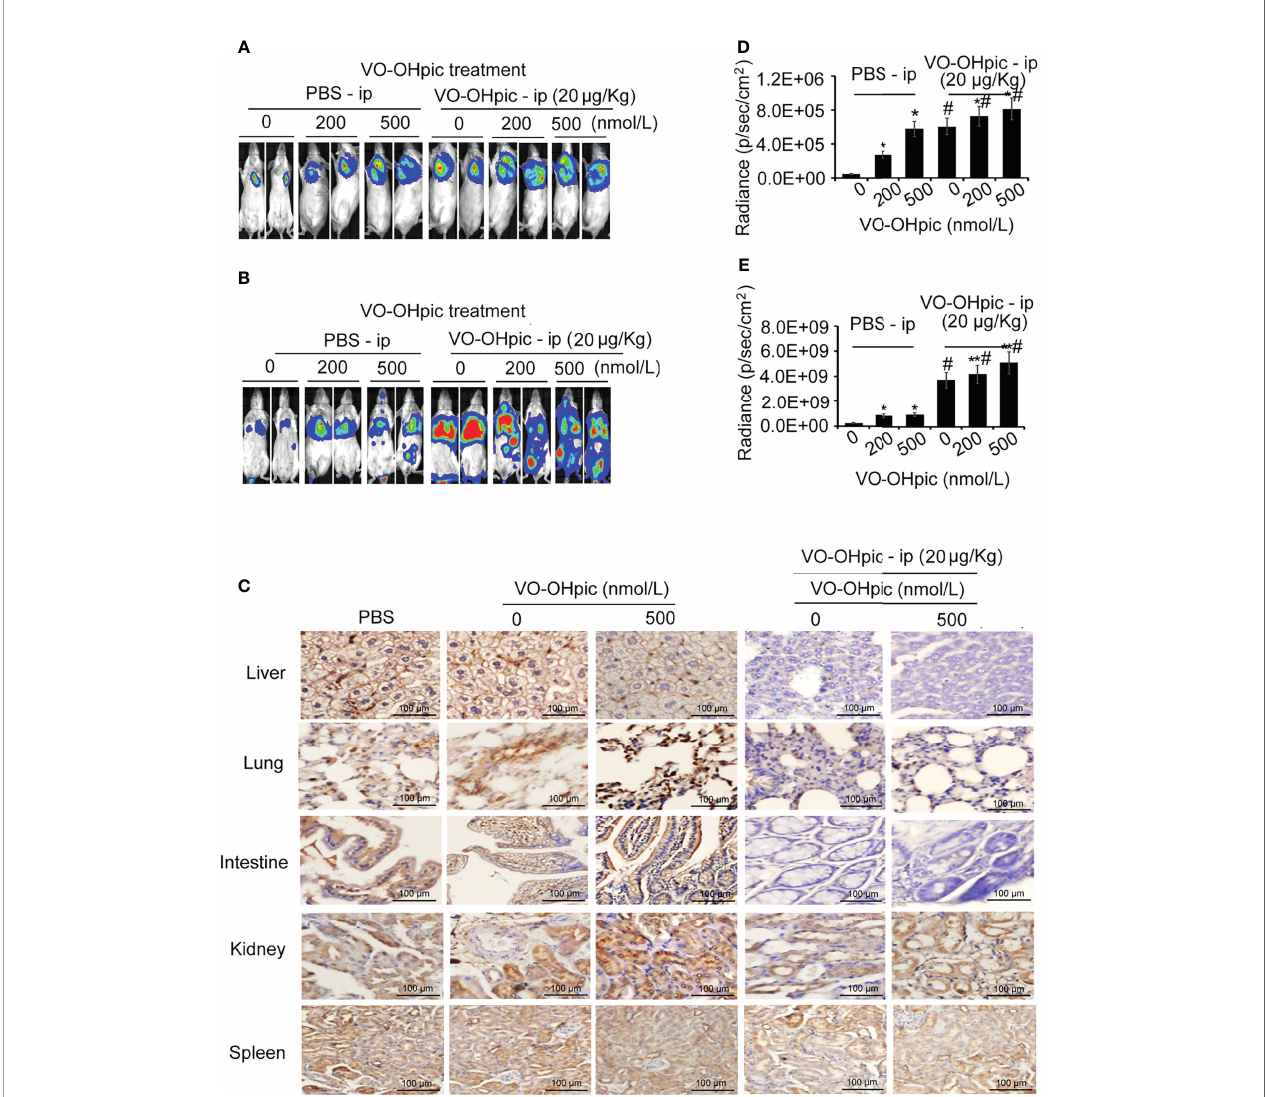
FIGURE 5 | PTEN-de fi cient breast cancer cells showed greater proliferation and metastasis potential in hosts with low PTEN function. 4T1-luc cells treated with VO- OHpic were inoculated via the breast fat pad or tail vein into Balb/c mice intraperitoneally injected with VO-OHpic, to establish a local model (A) and an organ metastasis model (C) . Flux intensity of breast tumors in situ (B) and distant metastases (D) were signi fi cantly increased in mice treated with PTEN inhibition in vivo and simultaneous inoculation of PTEN-de fi cient 4T1-luc cells, compared with mice treated with cellular or in vivo PTEN inhibition alone. PTEN protein expression levels in the lung, liver, intestine, and kidney were observed by immunohistochemistry under light microscopy (original magni fi cation, 20×) (E) . Compared with 0 nmol/L VO-OHpic group, * P <0.05, ** P <0.01. Compared to PBS - ip group, # P